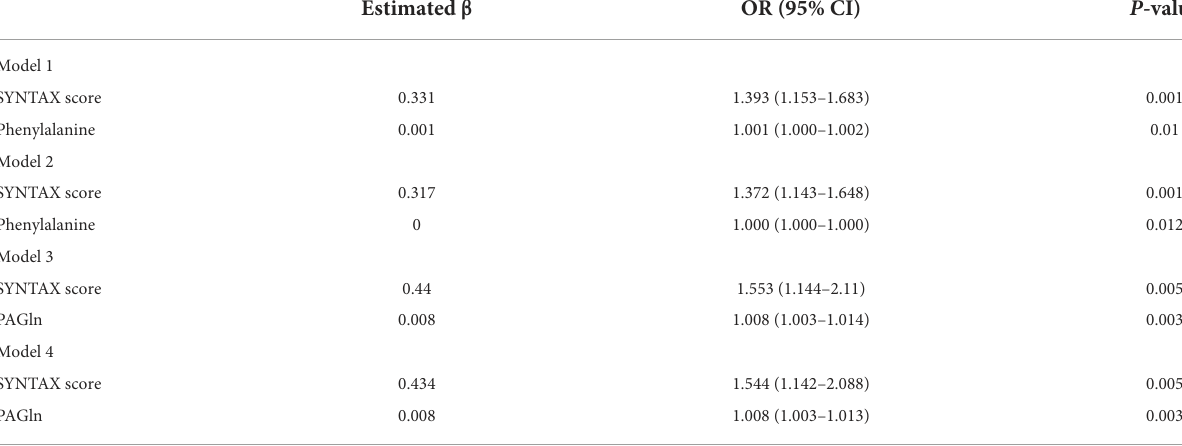
TABLE 4 Multiple logistic regression analyses for independent risk factors of